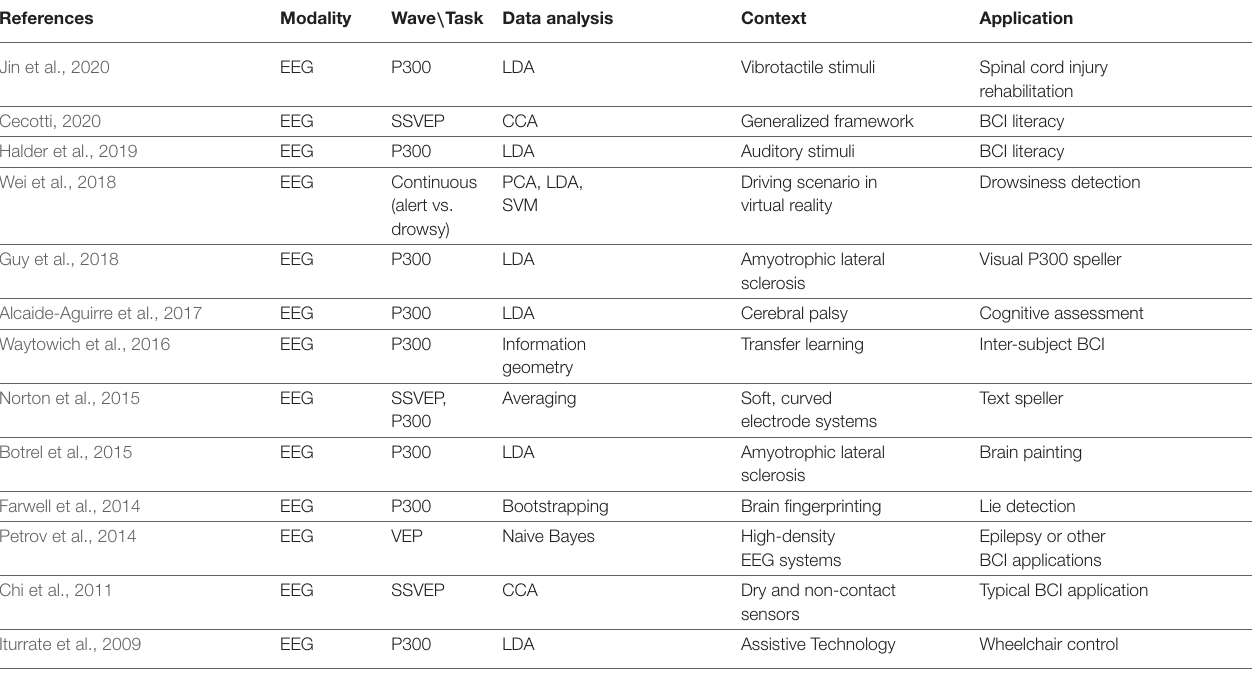
TABLE 3 | A summary of non-sensorimotor rhythms and electroencephalography-based brain computer interface (BCI)